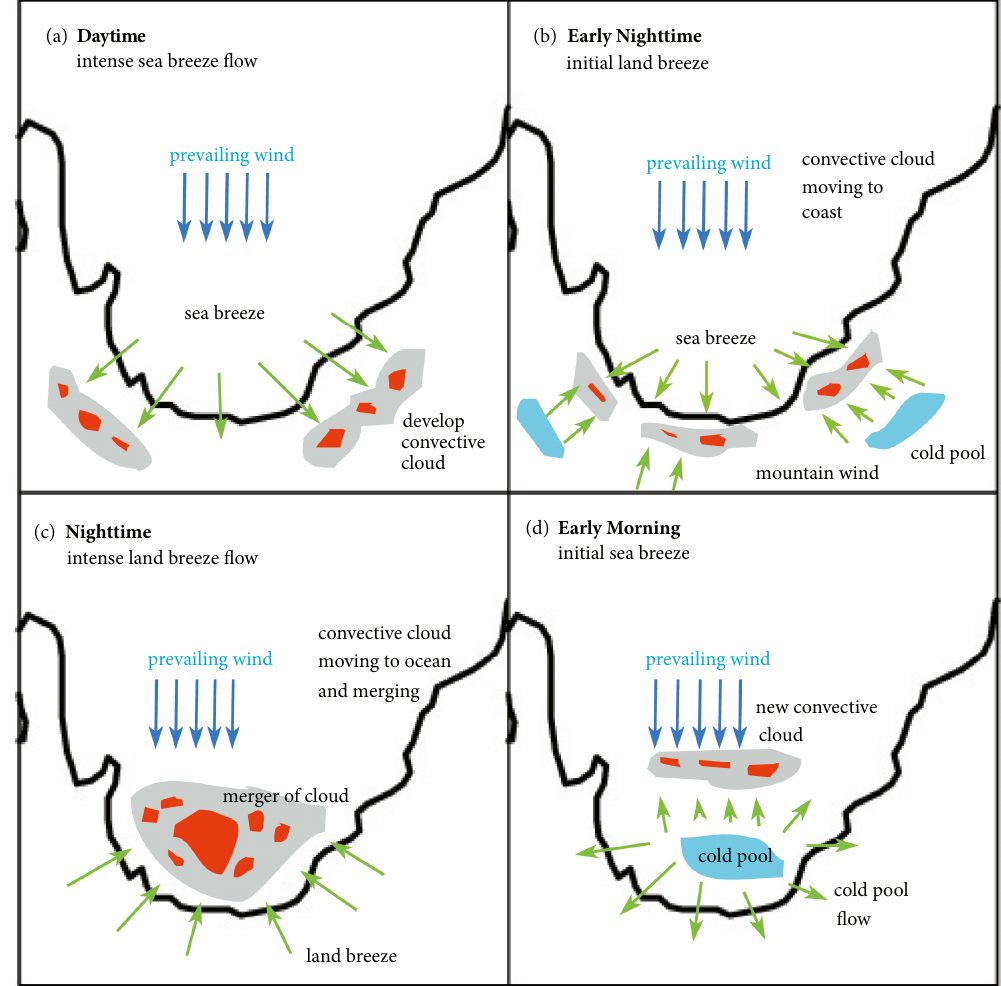
Figure 8: Schematic of rainfall and migration during (a) daytime, (b) early nighttime, (c) nighttime, and (d) early morning.